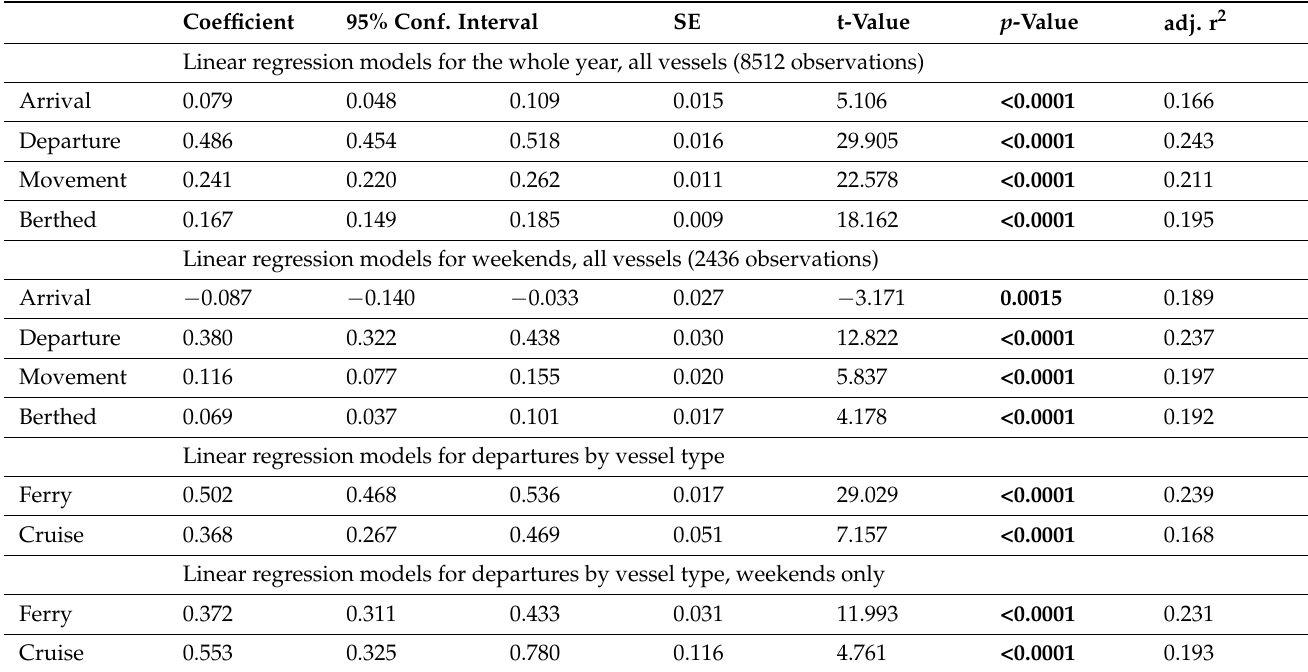
Table 8. Multivariable linear regression analysis results for vessel arrivals, departures, movement and laying alongside to the logarithm of NO 2 hourly mean concentrations controlled for wind direction, wind speed and time of day at West Harbour in 2019. p -values less than 0.05 in bold.